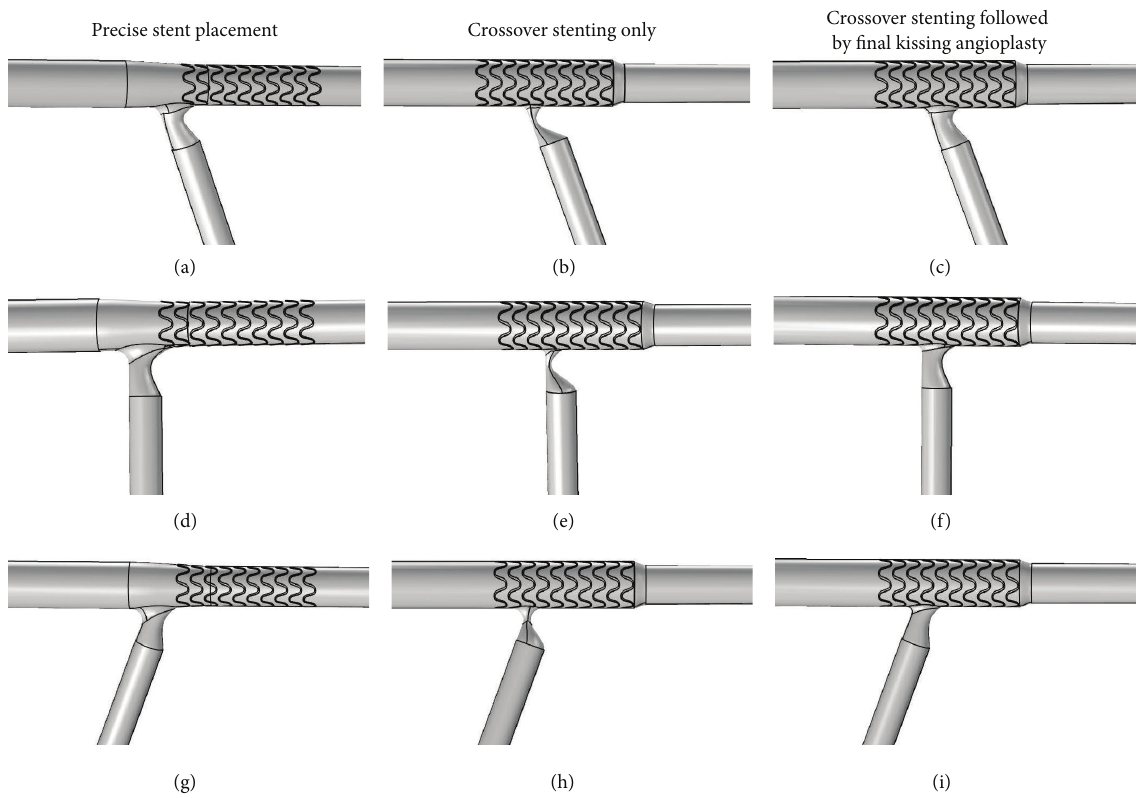
Figure 1: Idealized models of considered stenting techniques under different bifurcation angle conditions. (a), (b), and (c) illustrate stenting techniques under 70 ∘ bifurcation angle condition; (d), (e), and (f) under 90 ∘ bifurcation angle condition; (g), (h), and (i) under 110 ∘ bifurcation angle